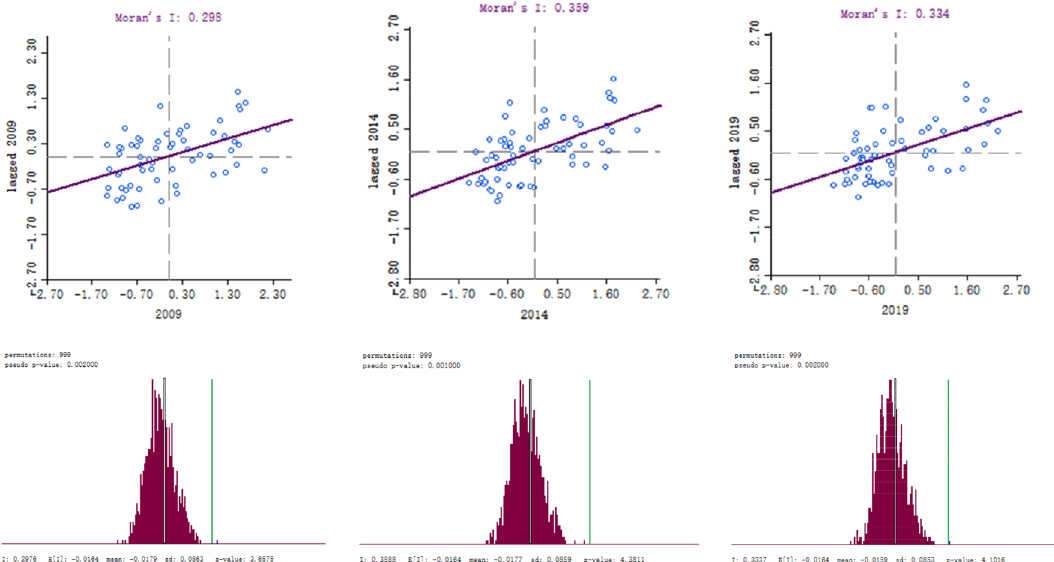
Figure 6. Lisa Scatter diagram and inspection of water ecological security in 62 Cities in 2009, 2014 and